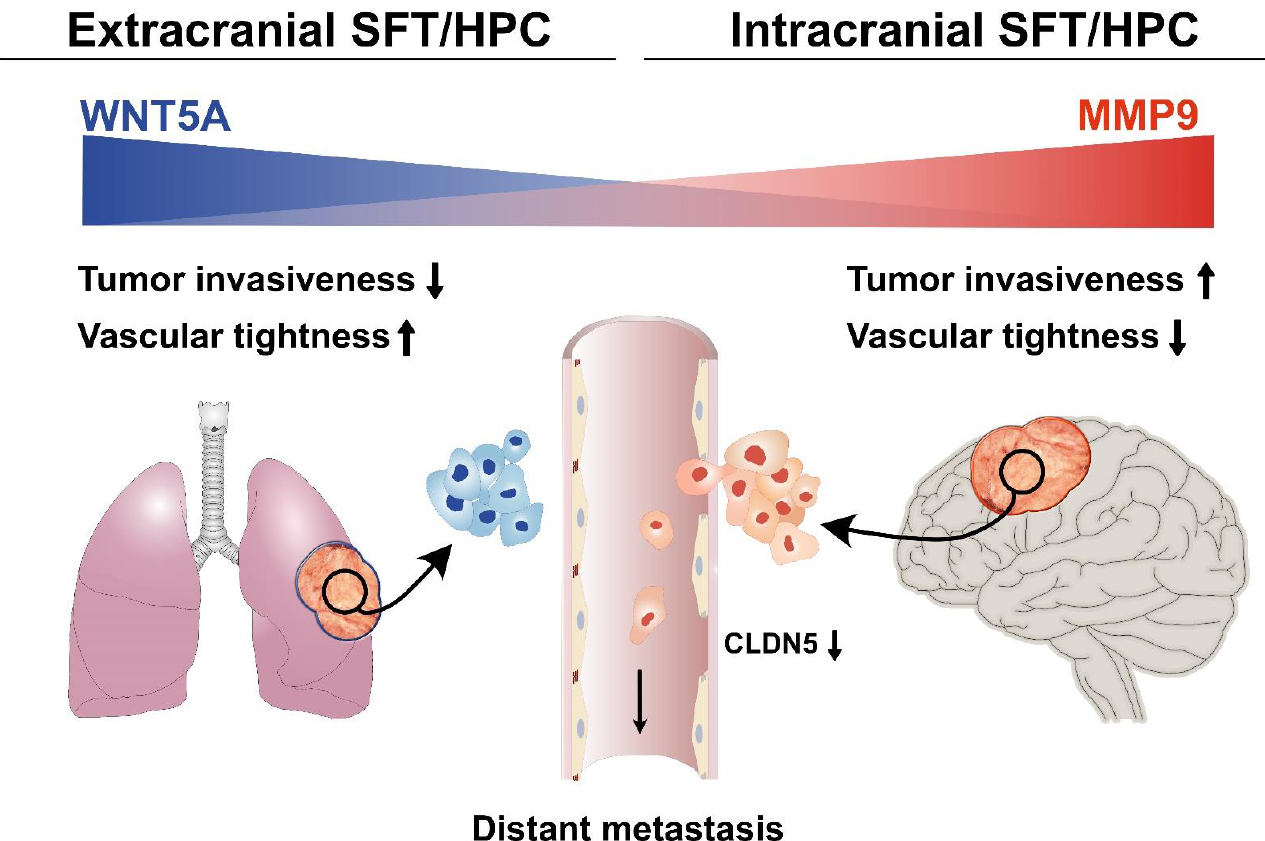
Figure 6. Hypothetical mechanism of extracranial metastasis of ic SFT/HPC. Compared to ex SFT/HPC, ic SFT/HPC shows a decreased expression of WNT5A, which maintains vascular tightness in the central nervous system and increased expression of MMP9, which promotes tumor-cell intravasation. Decreased expression of CLDN5, a marker of vascular tight junctions, in ic SFT/HPC is supportive of the hypothesis.